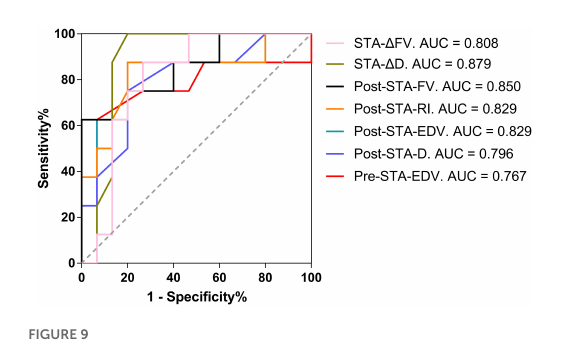
FIGURE9 The AUC for the collateral development after EDAS. AUC, area under the Receiver Operating Characteristic curve; EDAS, encephalo-duro-arterio-synangiosis; STA, superficial temporal artery; 1 , the difference between postoperative and preoperative parameters; FV, flow volume; D, inner diameter; Post, postoperative; RI, resistance index; EDV, end-diastolic velocity; Pre, preoperative.